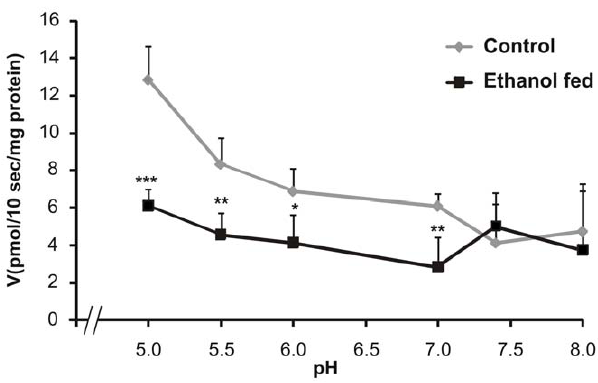
Figure 2. Uptake of 5-[ 14 C]-MethylTHF in the rat PPMV as a function of pH optimum. Uptake was measured by varying the pH of incubation buffer [100 mM NaCl, 80 mM mannitol, 10 mM HEPES, 10 mM 2-morpholinoethanesulfonic acid from 5.0 to 8.0, keeping intravesicular pH 7.4 at 0.5 m M substrate concentration for 10 sec. Each data point is mean 6 SD of 4 separate uptake determinations. *p , 0.05,